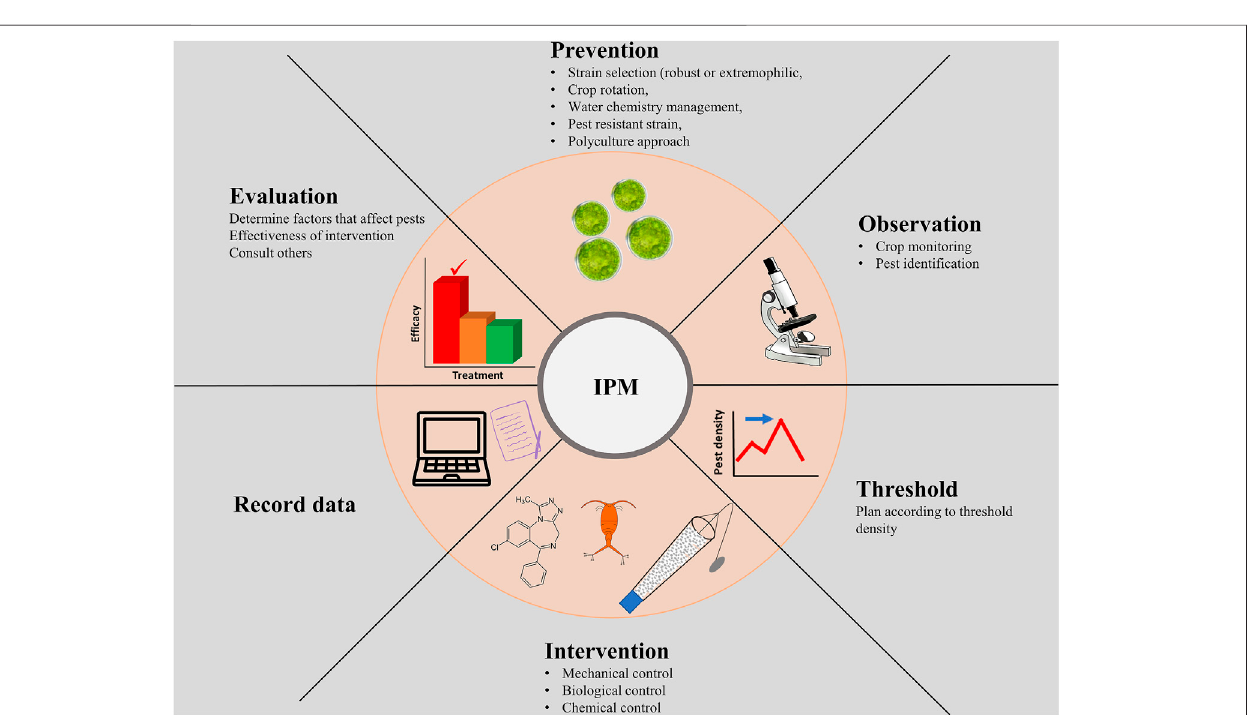
Frontiers in Energy Research |